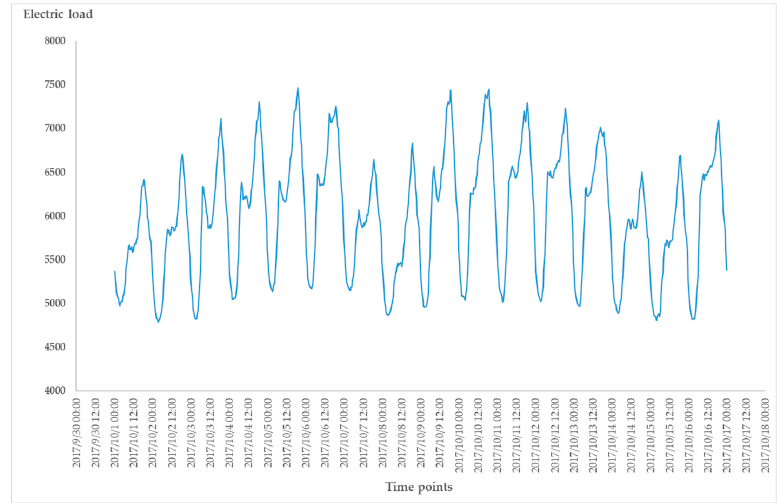
model) always follows closely with the black real line (actual electric load), whether climbing up the peak or climbing down the hill. Figure 3. The seasonal tendency of actual half-hour electric load in Example 1.